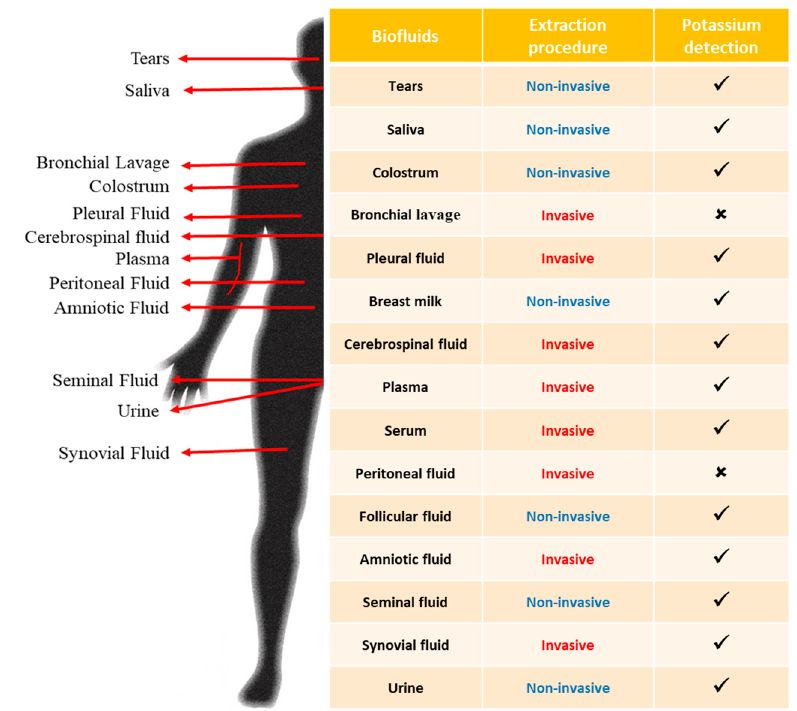
Figure 1. List of commonly available bodily fluids showing their nature of the extraction procedure and general feasibility of potassium detection from those fluids.